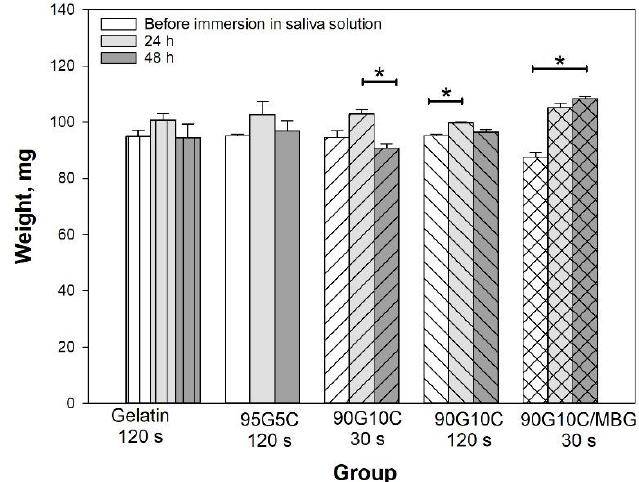
Figure 4. Effect of composition on hydrated gel weight. The gel samples, including pure gelatin, 95G5C, 90G10C and 90G10C containing 20% MBG, which were irradiated for a designated time, were immersed in a pH 7 artificial saliva solution, and weighted every 24 h. Data are presented as the mean ± SD (n = 9) and were analyzed using the nonparametric Kruskal–Wallis H-test. Differences of p <0.05 were considered statistically significant. (*) denotes a significant difference (p < 0.05)